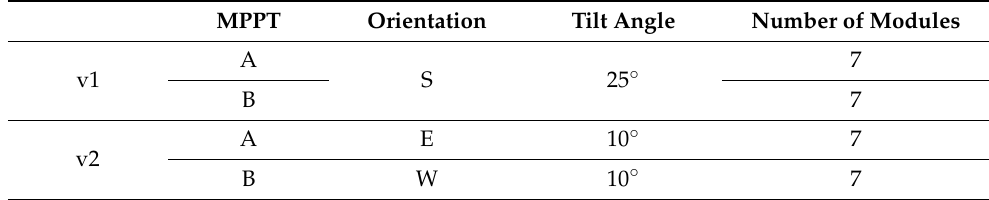
Table 1. Electrical configuration of circuits connected to the inverter in the household.